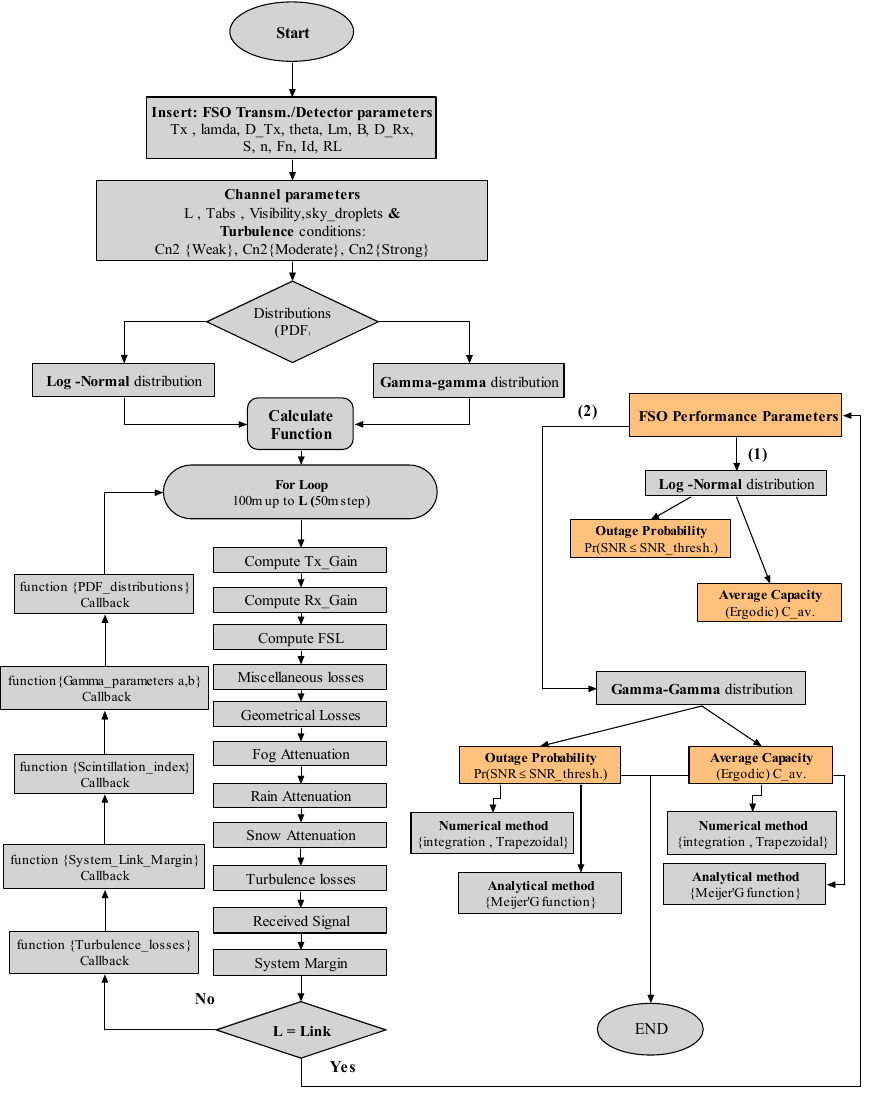
Figure 1. Block diagram of the computational tool.